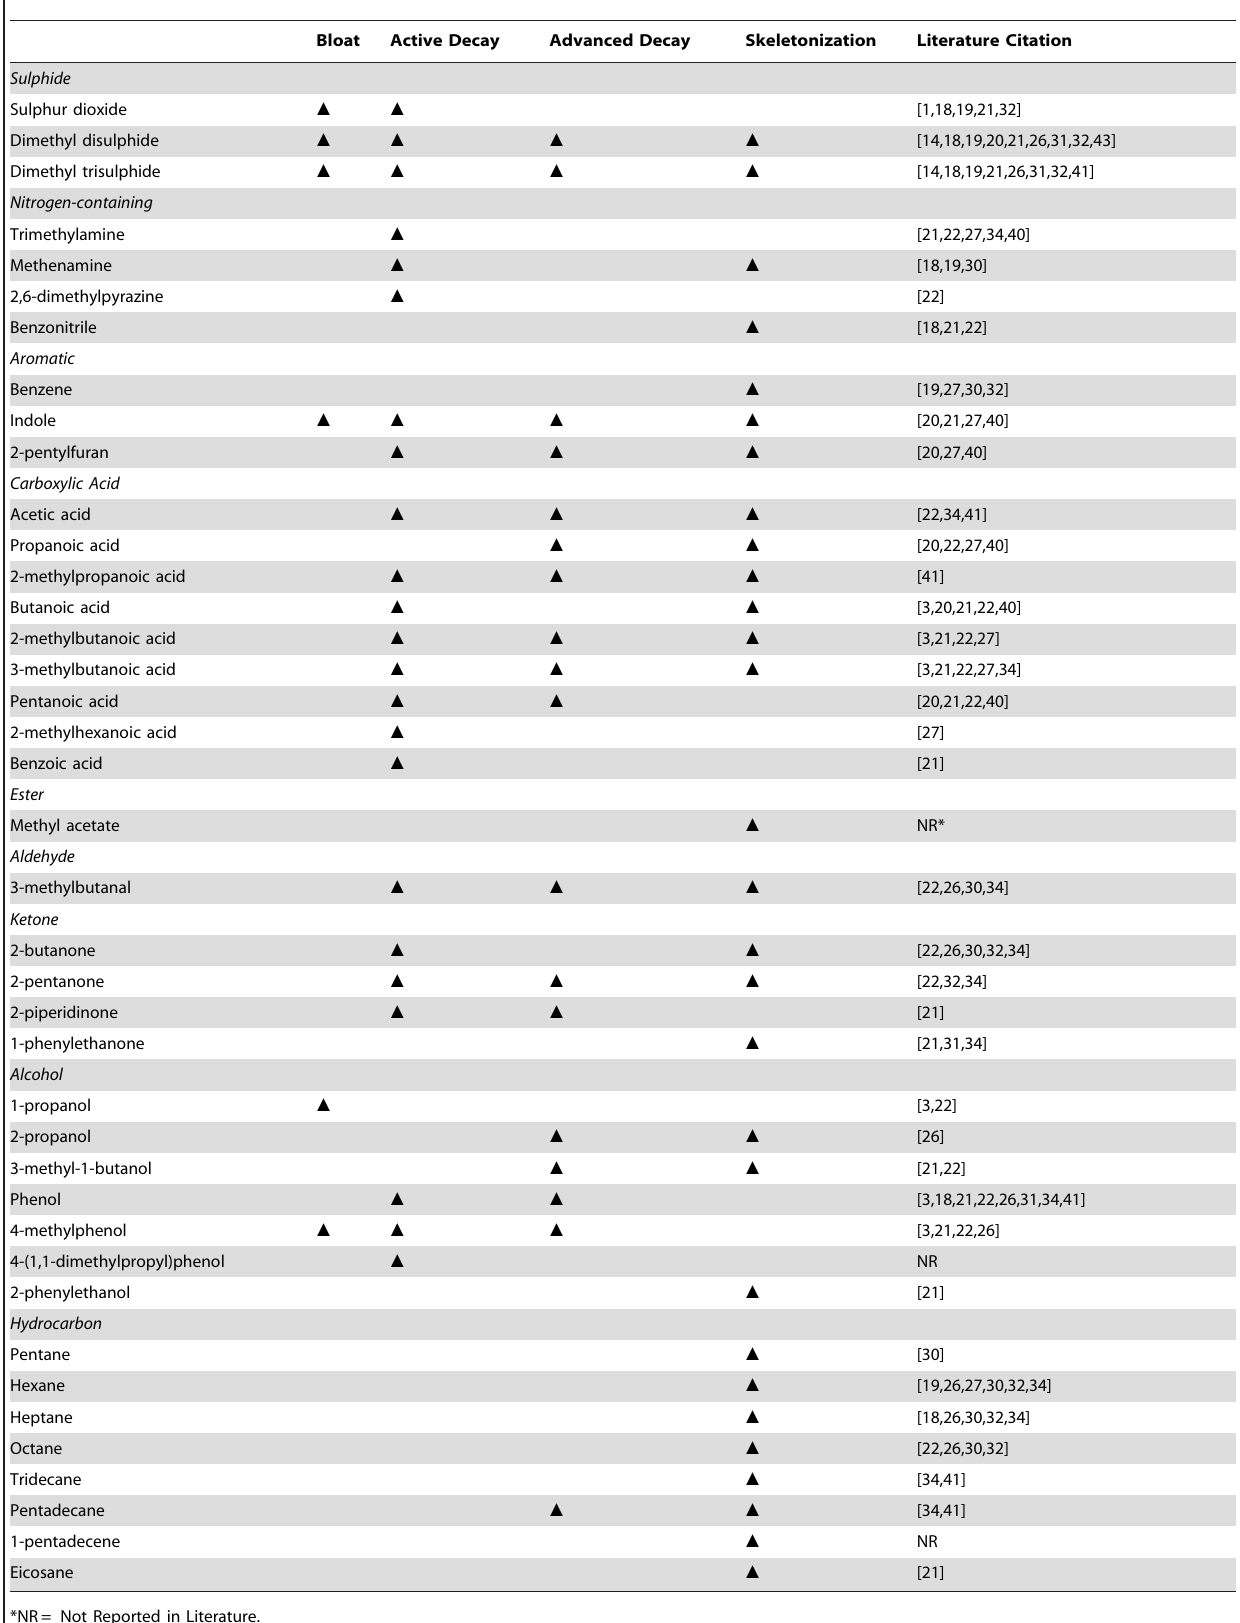
Table 1. Major VOCs consistently identified in experimental air samples throughout the decomposition stages (excluding fresh).